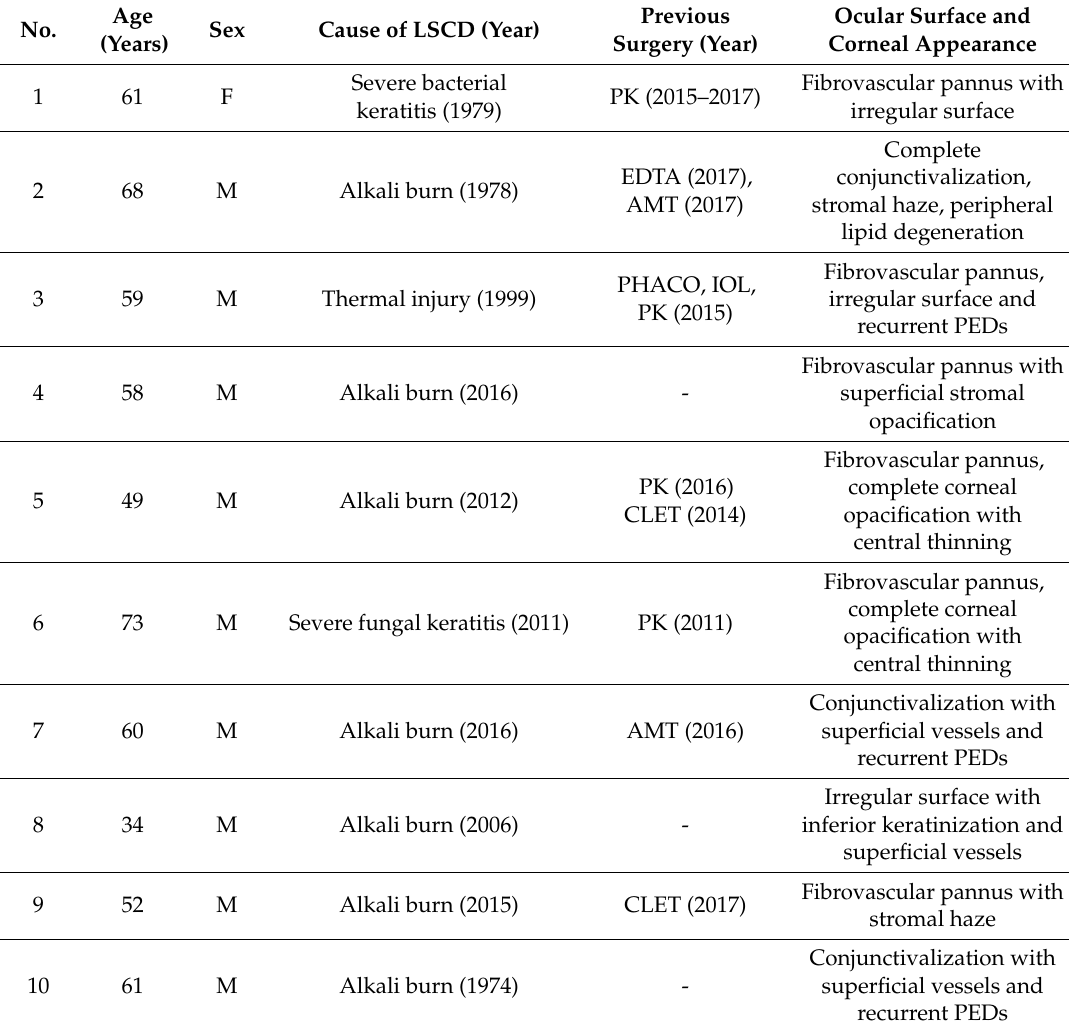
Table 1. Demographic characteristics and clinical history of